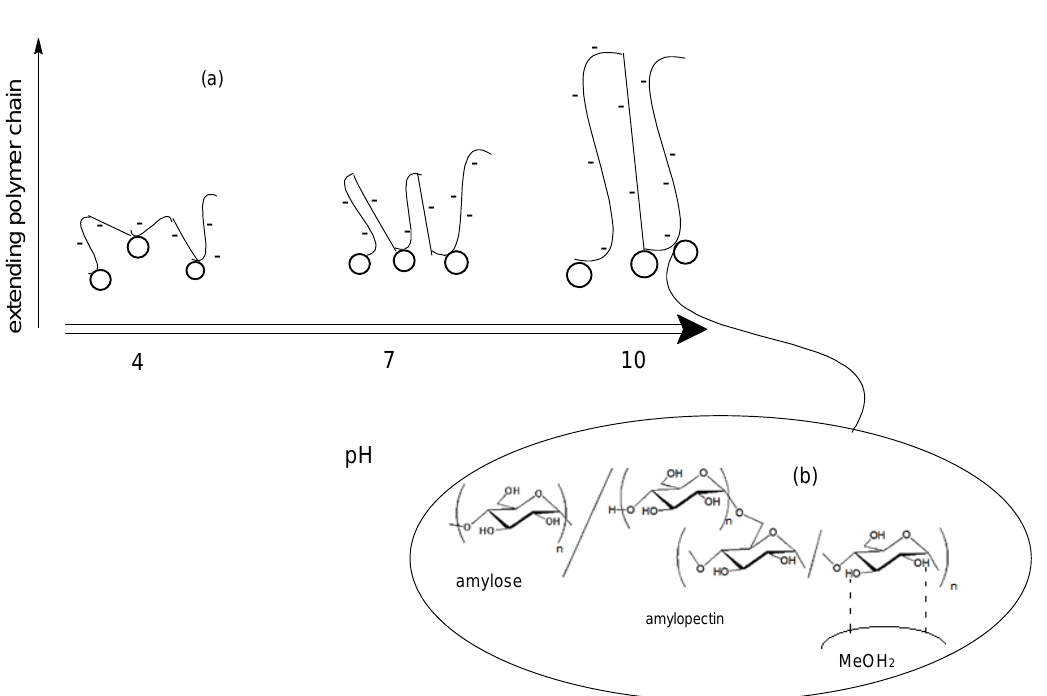
Figure 2. ( a ) Flocculation mechanism in increasing pH and ( b ) absorption of Me(OH) 2 on the Tacca leontopetaloides biopolymer flocculant (TBPF) surface.